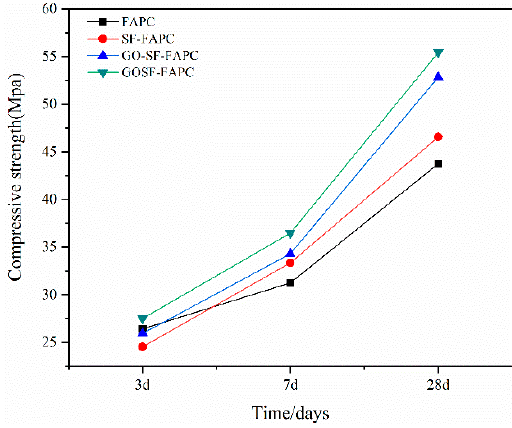
Figure 10. Compressive strength of samples in experiment 1.